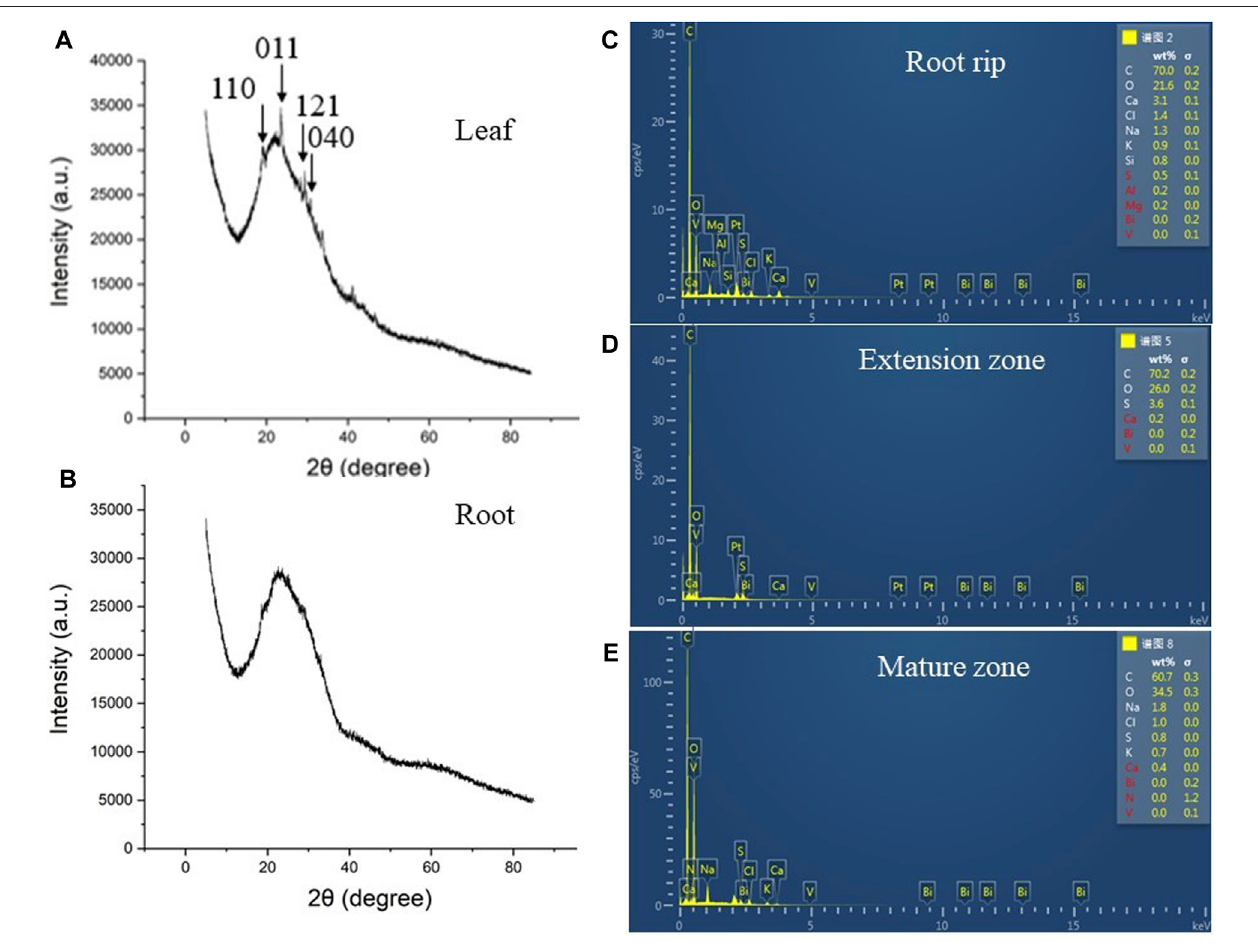
FIGURE 6 | XRD analysis of leaves and taproots and ESD analysis of taproots. (A) : XRD analysis of leaves in 200 μ g ml − 1 BV treatment. (B) : XRD analysis of taproots in 200 μ g ml − 1 BV treatment. (C) : ESD analysis of root tips in taproots in 200 μ g ml − 1 BV treatment. (D) : ESD analysis of the extension zone in taproots in 200 μ g ml − 1 BV treatment. (E) : ESD analysis of the mature zone in taproots in 200 μ g ml − 1 BV treatment. The arrow indicates the characteristic peak of BV. N (cid:2)